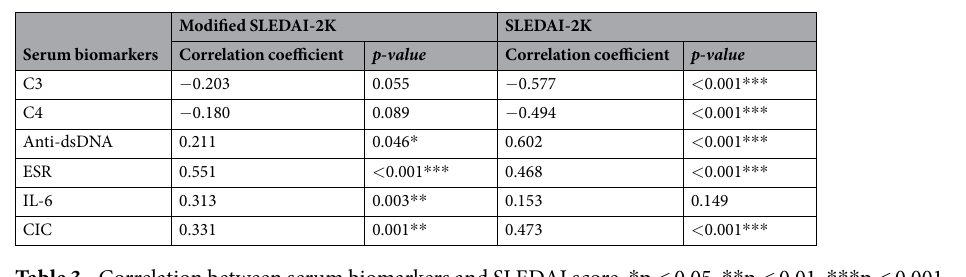
Table 3. Correlation between serum biomarkers and SLEDAI score. * p < 0.05, ** p < 0.01, *** p <